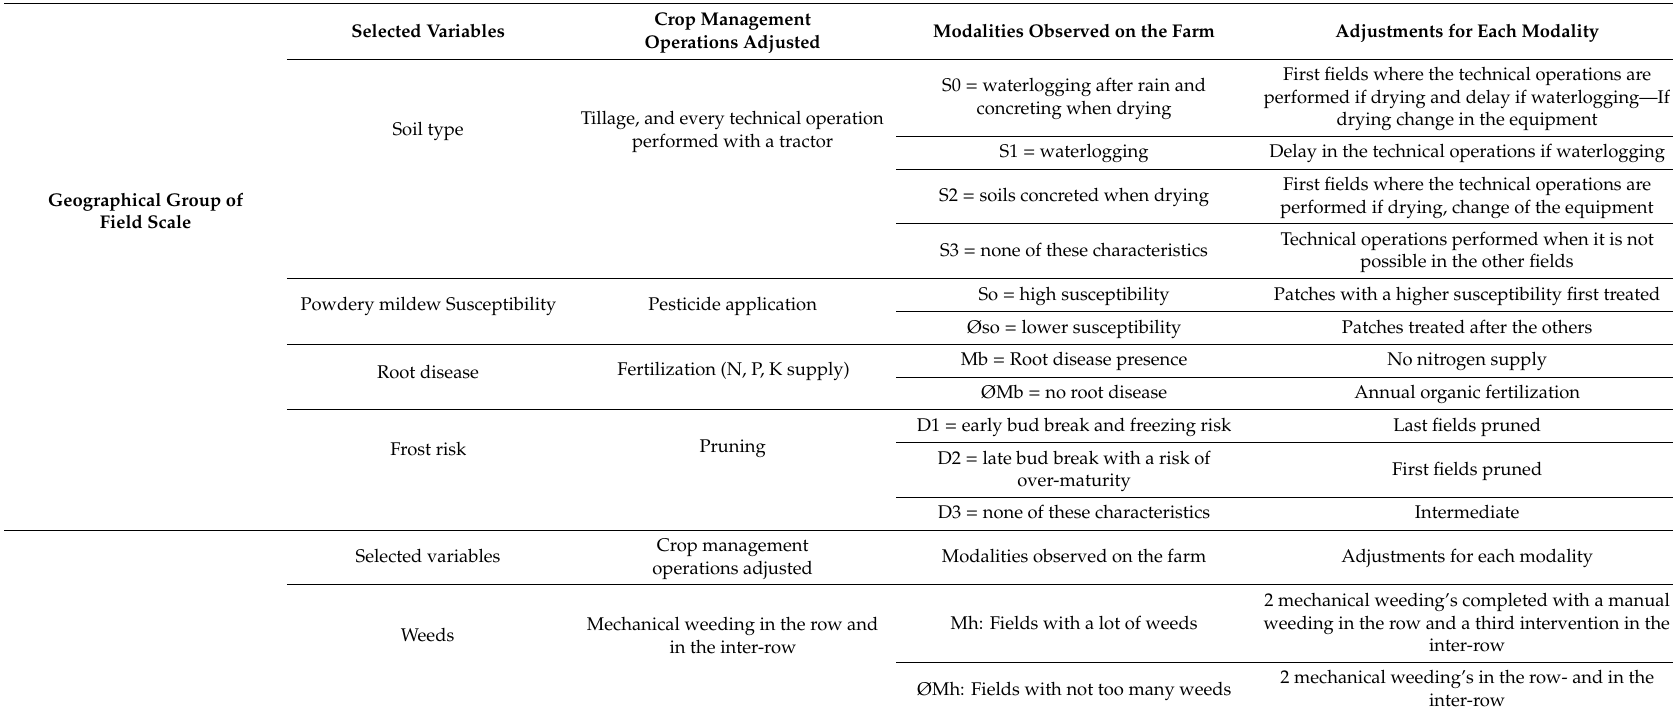
Table 1. Characteristics that are taken into account to adjust the general crop management sequence for each field and their consequences on crop management at the geographical group of fields scale and at field